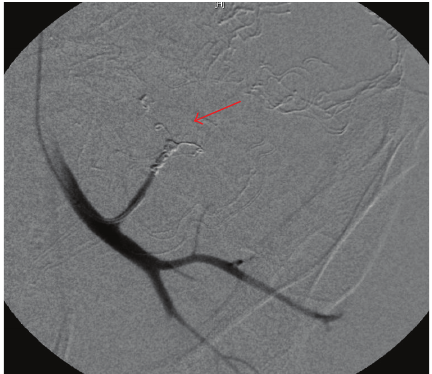
Figure 2: Angiography showing successful coiling of the bleeding artery.